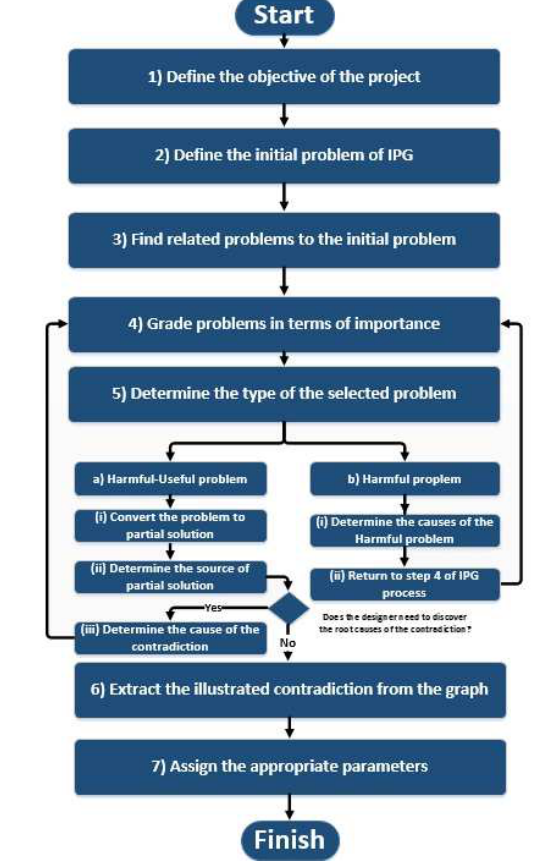
Figure 7. Process of Inverse Problem